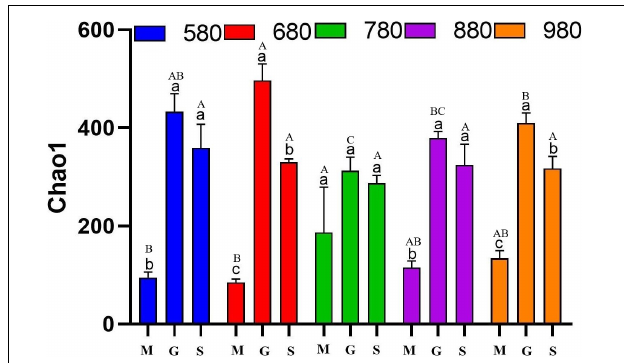
FIGURE 3 | The α diversity indices of phyllosphere fungi among different elevations and growth stages. Comparison of α diversity of rice phyllosphere fungi at different growth stages at the same elevation, M: seedling stage, G: heading stage, S: mature stage. Capital letters indicate significant differences between different growth stages at the same growth stage. Lowercase letters indicate significant differences at different elevations at the same elevation.